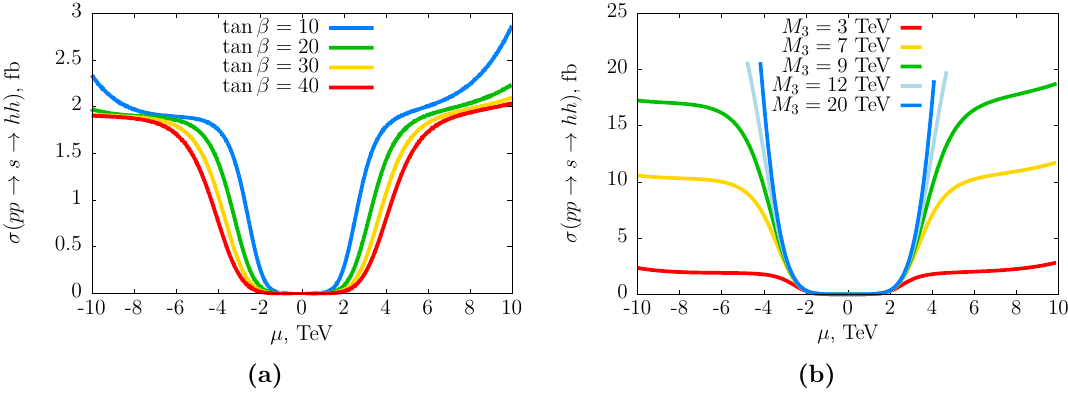
Figure 6. Resonant di-Higgs production cross section of the process pp of (cid:22) for di(cid:11)erent values of tan (cid:12) (a) and M 3 (b), calculated for p S = 13 TeV. Other parameters are (cid:12)xed as m s = 1 TeV, m A = 5 TeV, M 1 = M 2 = 1 TeV, p F = 20 TeV, K p = 2, K d = 1 : 6; M 3 = 3 TeV (a) and tan (cid:12) = 10